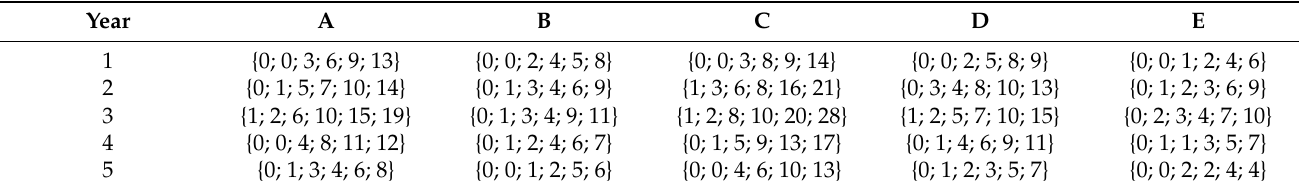
Table 1. Impact of shortcomings in healthcare attention on each cause of death (A, B, C, D, E) and each year.